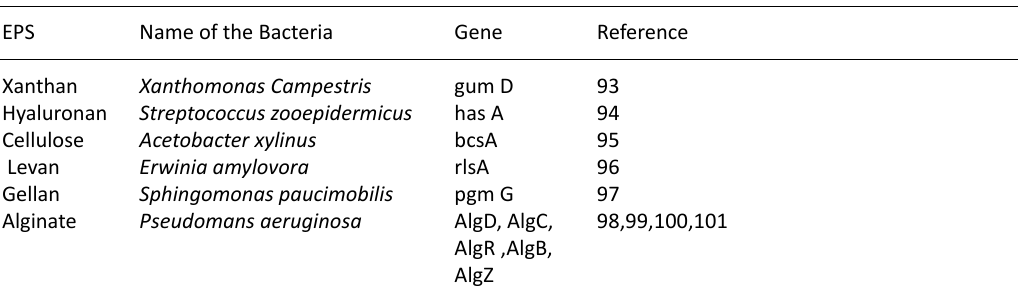
Table 3. List of genes responsible for EPS production EPS Name of the